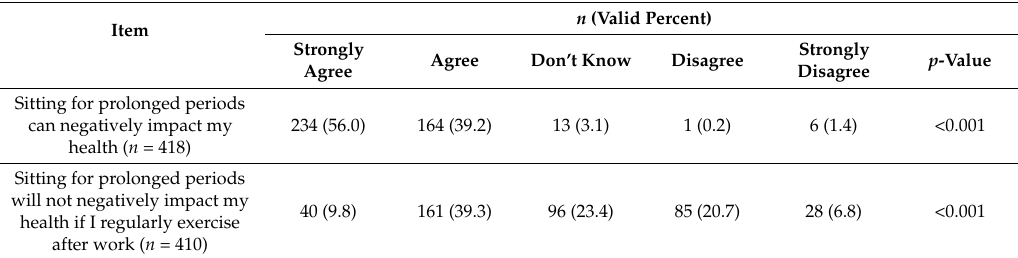
Table 3. Beliefs about the effect of sedentary behavior on health.